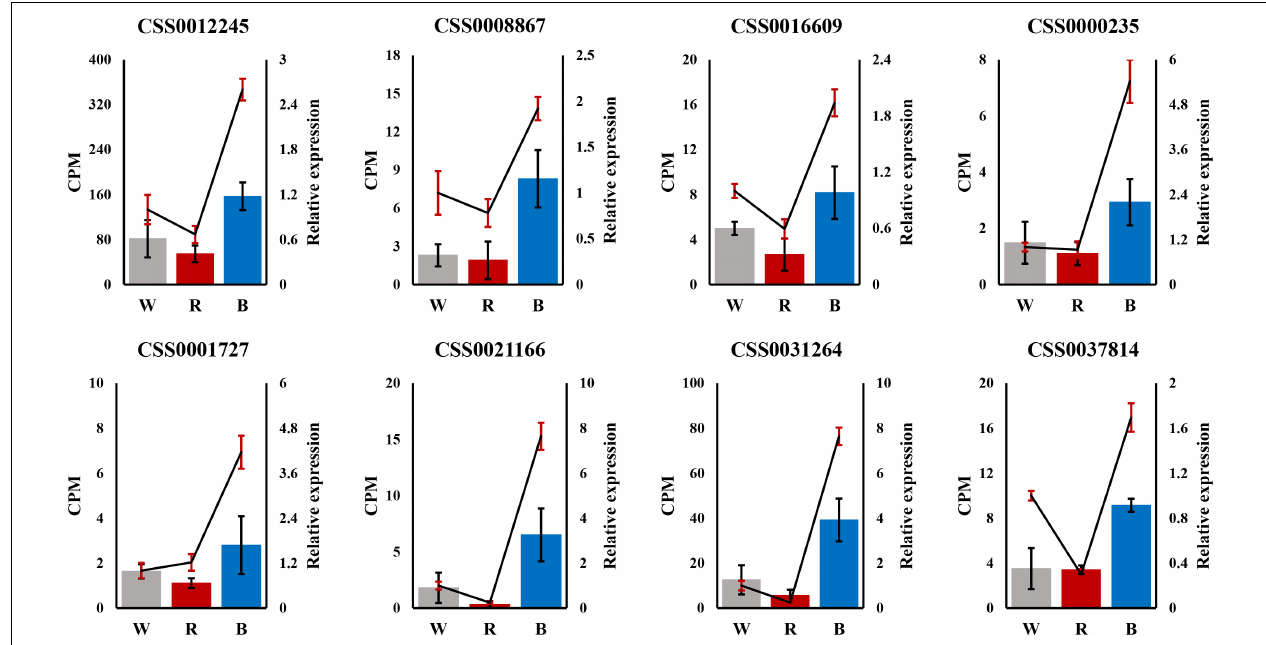
FIGURE 7 | Validation of 8 hub genes by qRT-PCR. The left Y-axis represents counts per million (CPM) values for Oxford Nanopore Technoligies (ONT) RNA-Seq, and the right Y-axis represents relative qRT-PCR expression levels. In the figure, the bars represent ONT RNA-Seq, and the lines represent qRT-PCR.